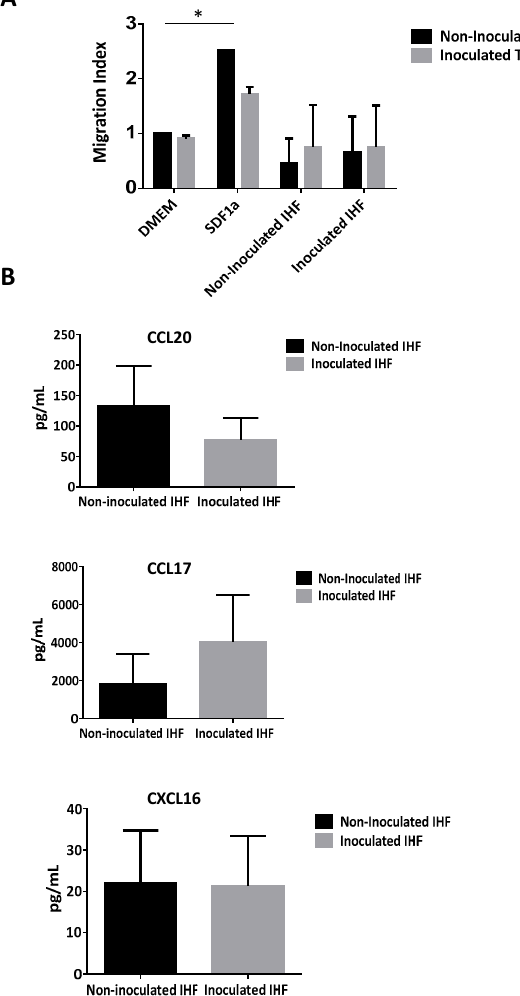
Figure 7. Tregs cannot be recruited by primary human intra-hepatic fibroblasts even upon HCV inoculation. Tregs recruitment by in vitro inoculated primary human intra-hepatic fibroblast (IHF) was evaluated by a Boyden chamber assay ( A ). Results are expressed as mean values of quintuplicate of two independent experiments and presented in an index of migration of Tregs ± SEM bars. Secretion of chemokines CCL20, CCL17 and CXCL16 has been examined by ELISA ( B ). Results are expressed as the mean of two independent experiments and presented in pg / mL ± SEM bars comparing secretion by inoculated IHF (light grey bars) versus non-inoculated IHF (dark bars). p ≤ 0.05